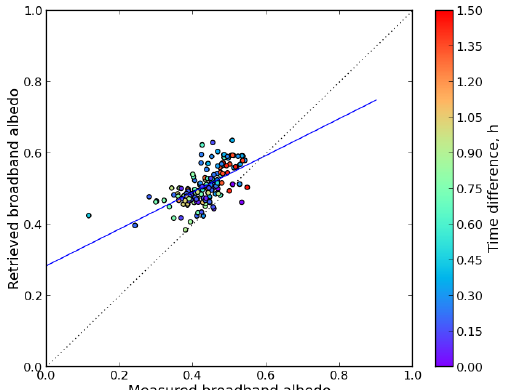
Figure 6. Correlation between broadband albedo retrieved from air- borne measurements and from a satellite overflight, respectively, for the 4 June 2008, MELTEX campaign (bottom panel of Fig. 3) with respect to time difference. N = 147, R 2 = 0.39, RMS =